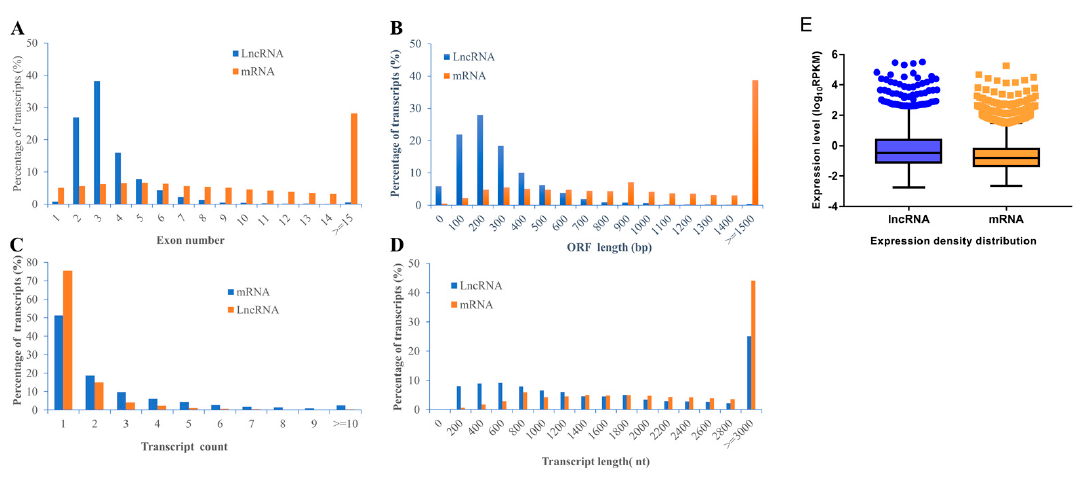
Figure 3. The comparison of features of lncRNAs and mRNAs. ( A ) Exon number. ( B ) ORF length. ( C ) Transcript count. ( D ) Transcript length. ( E ) Expression density distribution. Data are expressed by three independent experiments ( n = 3).